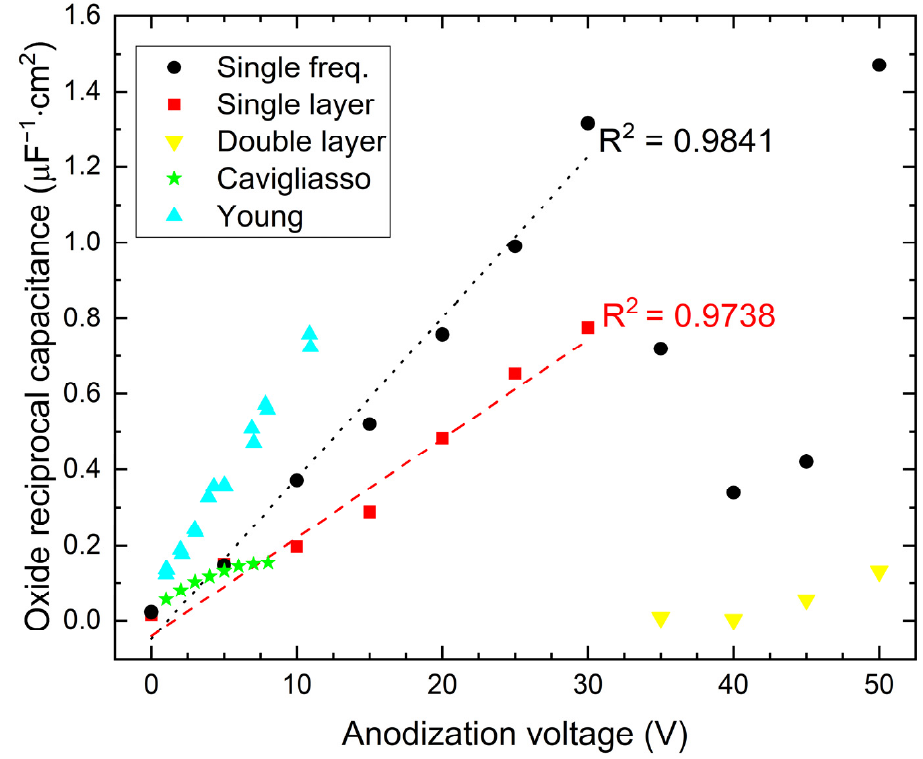
Figure 6. Oxide reciprocal capacitance as a function of anodization voltage for Nb oxide films.